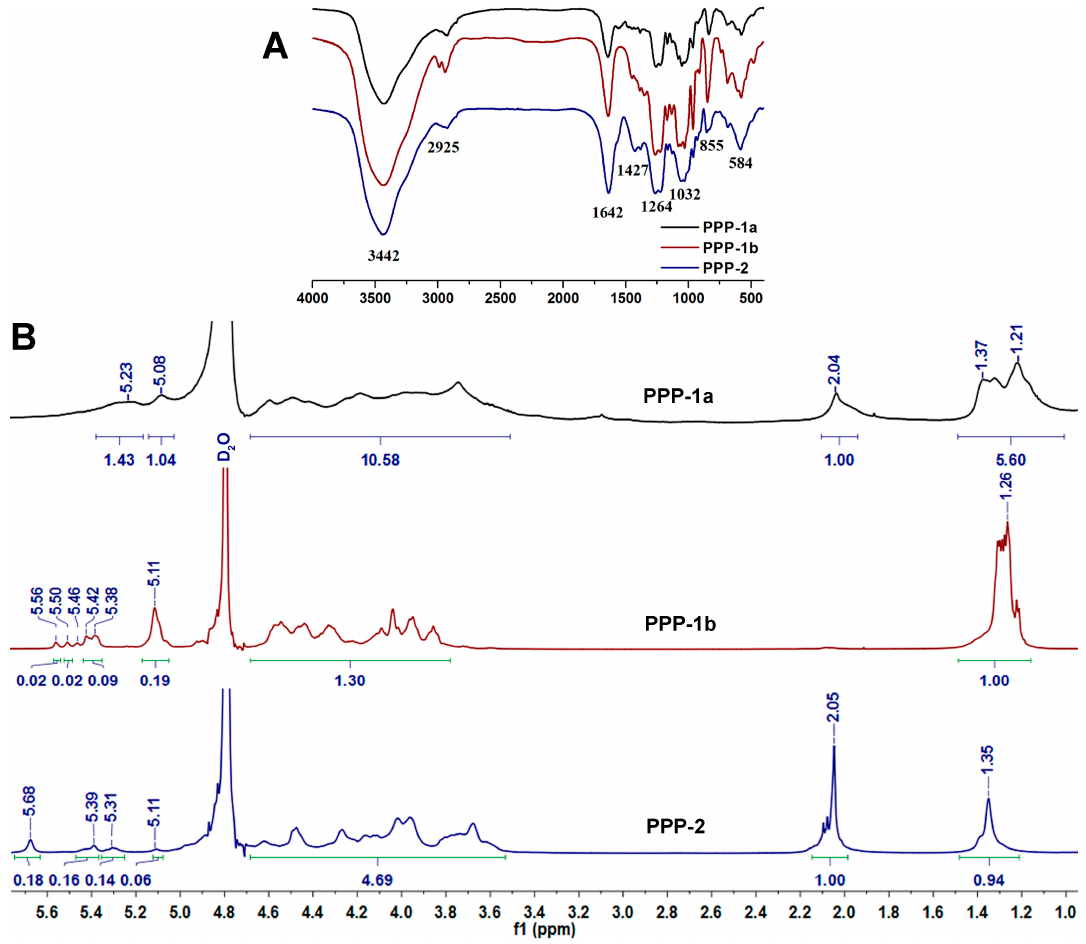
Figure 4. FI-IR ( A ) and 1 H-NMR ( B ) spectra of PPP-1a, PPP-1b and PPP-2.